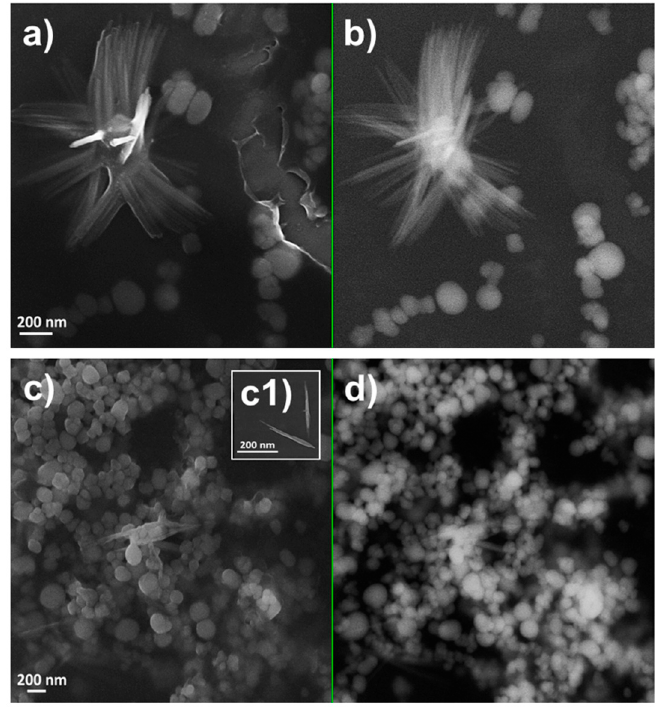
Figure 5. Scanning electron micrographs of ( a , b ) SeNSs MPV1_G_e and ( c , d ) SeNSs MPV1_P_e recovered from MPV1 cells grown for 120 h in the presence of glucose and 0.5 mM SeO 32- (( a ) InLens detector and ( b ) backscattered electron detector) or pyruvate and 0.5 mM SeO 32- (( c ) InLens detector and ( d ) backscattered electron detector) .